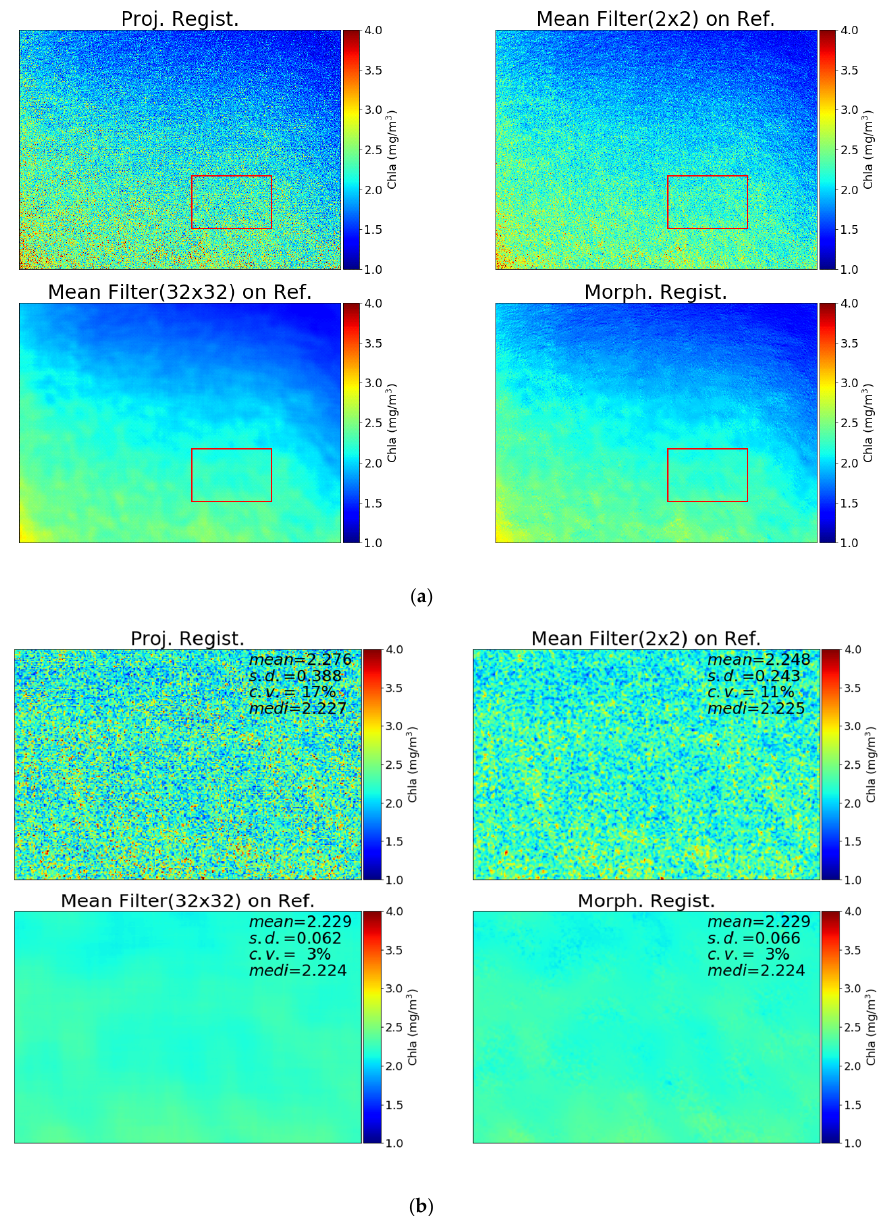
Figure 16. Scene-C acquired on 2019.08.31 at an altitude of 196 m. ( a ) Chla estimates from four different processings of R rs data; ( upper left ) before morphological registration, ( upper right ) after 2 × 2 mean filter on water reflectance, ( bottom left ) after 32 × 32 mean filter on water reflectance, and ( bottom right ) after morphological registration. ( b ) Magnified figures for the subset area marked in a red box in panel ( a ).